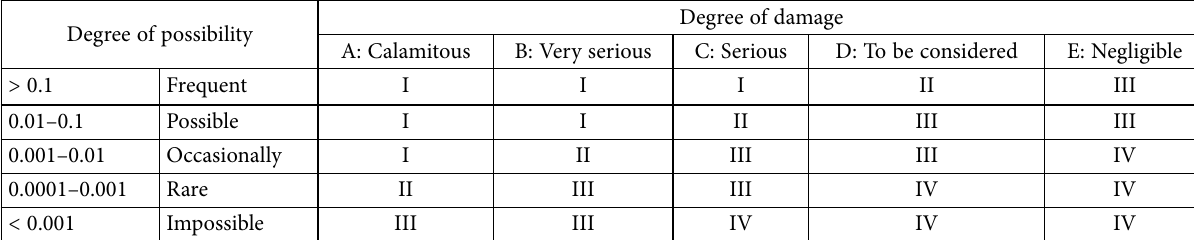
Table 3. Risk level determination